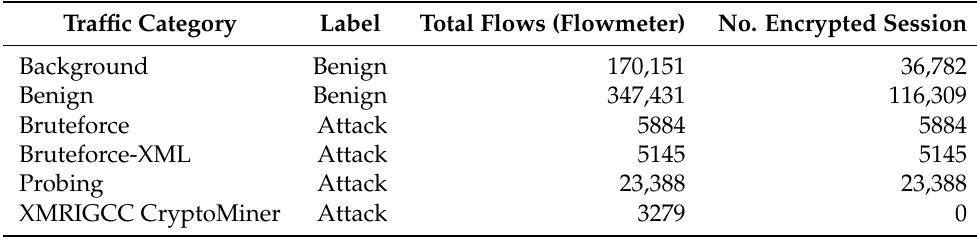
Table 2. Labeled features